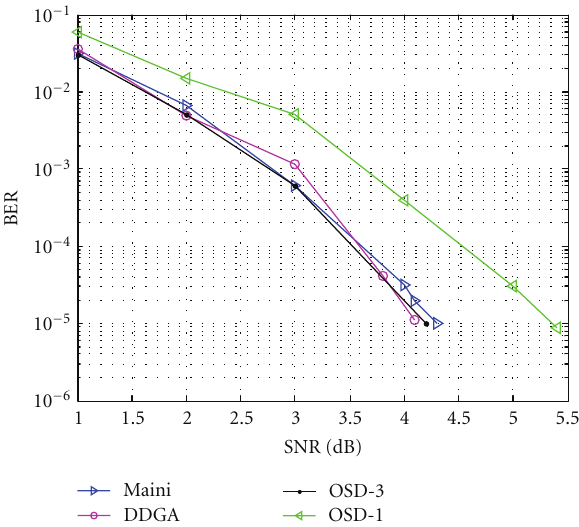
Figure 20: Performances of Maini, DDGA, OSD-3, and OSD-1 algorithms for QR (71,36,11) code.